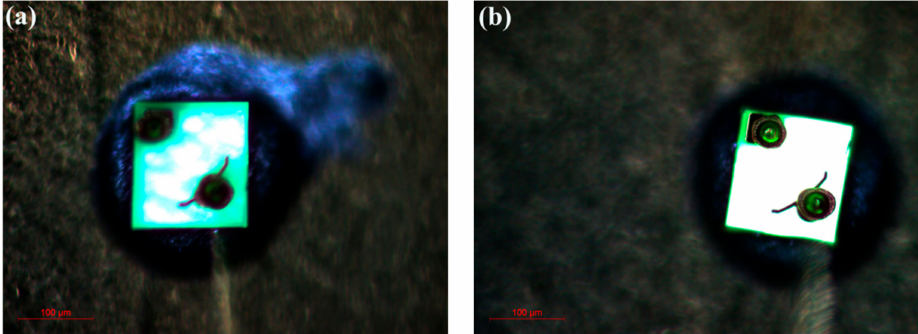
Figure 4. Micrographs of light emission for ( a ) Sample A and ( b ) Sample